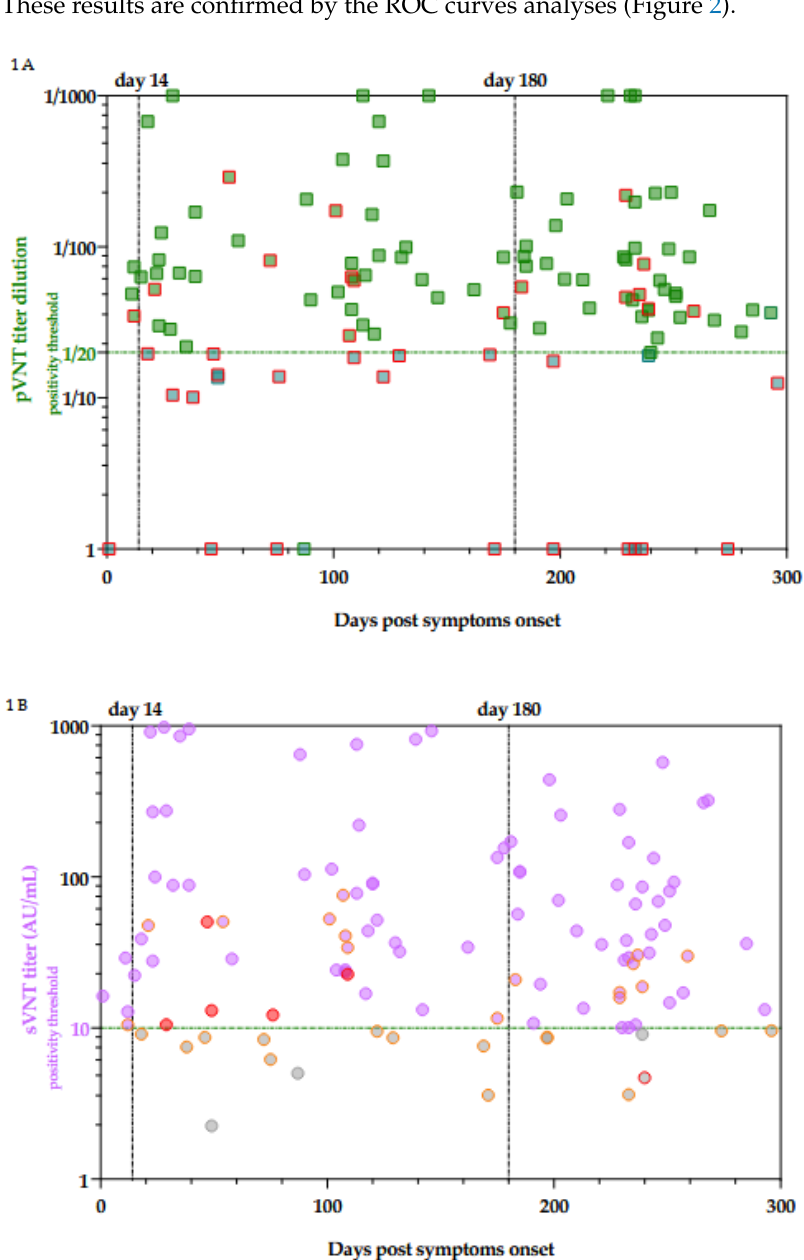
Figure 1. Evolution of NAbs titer in pVNT ( A ) and sVNT ( B ) as a function of days post symptoms onset. Green squared and purple dots are concordant results. Squares framed in red are those for which there is a discordant result between pVNT result and at least one of the six non-neutralizing immunoassays. Dots circled in orange are those for which there is a discordant result between sVNT and at least one of the six non-neutralizing immunoassays. Dots circled in red are those for which only sVNT was discordant. Red dots are those for which sVNT is discordant from pVNT. The details of these discrepancies are reported in Table 2.